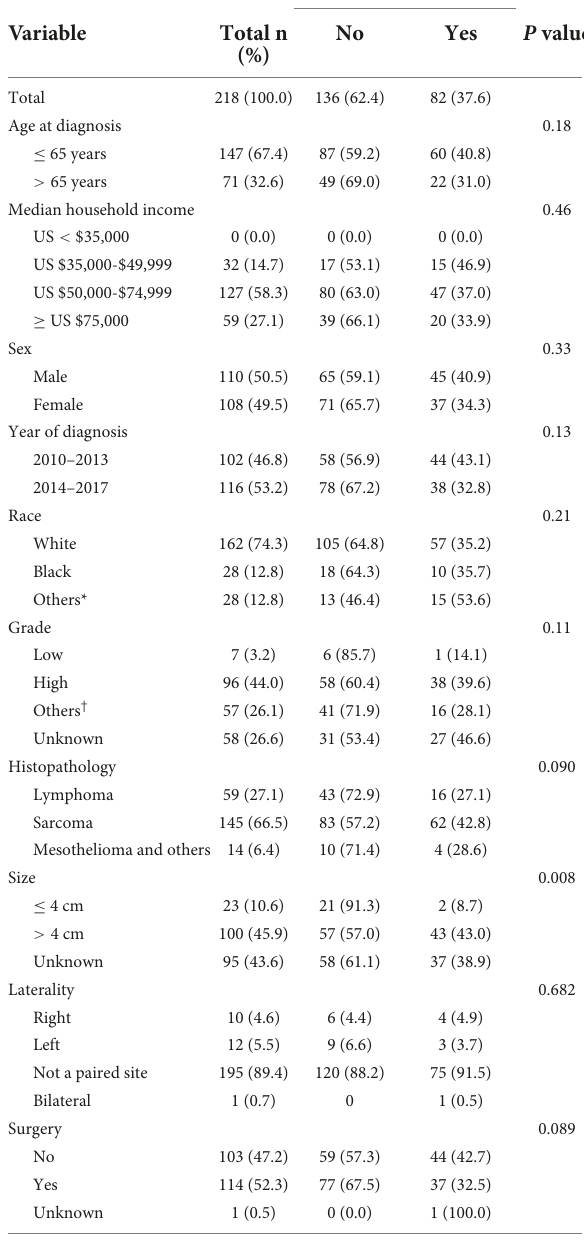
TABLE 1 Baseline characteristics of primary malignant cardiac